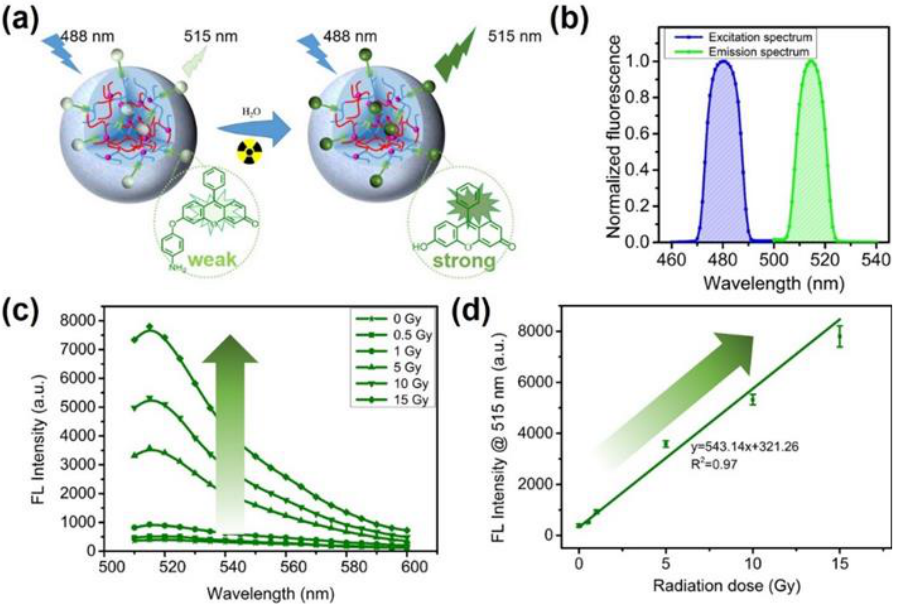
Figure 7. ( a ) Schematic illustration of the sensing mechanism and ( b ) the normalized FL spectra of PAAm-based nanogel dosimeters in response to X-rays. ( c ) The FL emission spectra and ( d ) FL intensity at 515 nm of the dosimeters with increasing X-ray doses. Adapted from ref. [72] with permission from American Chemical Society.